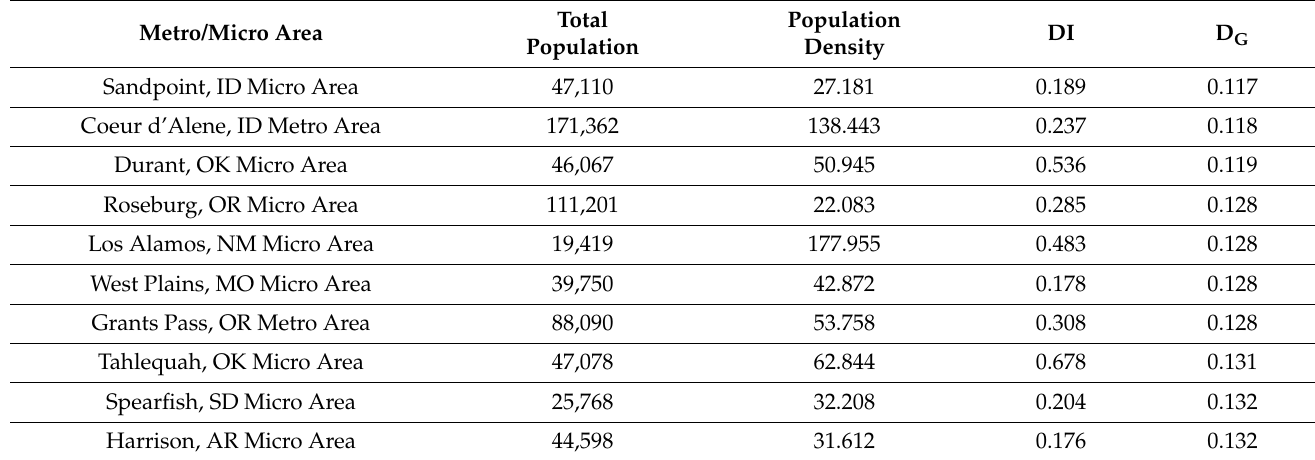
Table 4. Ten Lowest Metro/Micro Areas Multigroup dissimilarity Indices,